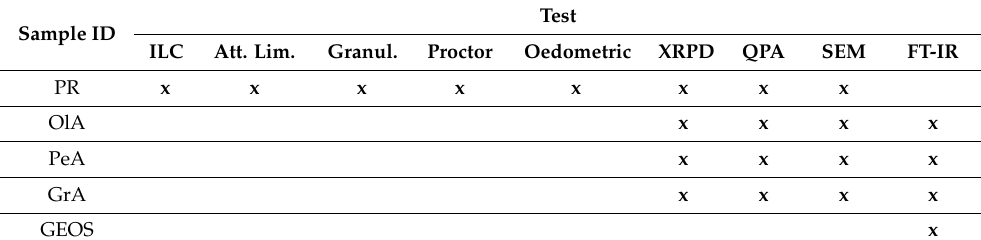
Table 8. Geotechnical and chemo-mineralogical analyses performed on raw materials before treatment. Sample